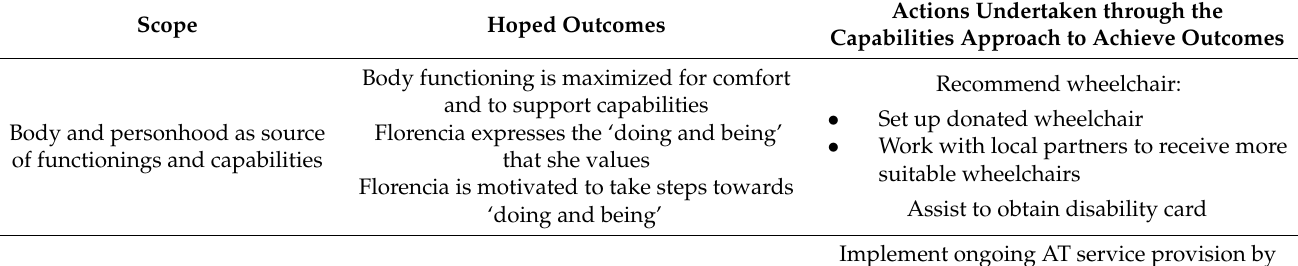
Table 3. Florencia with the capabilities